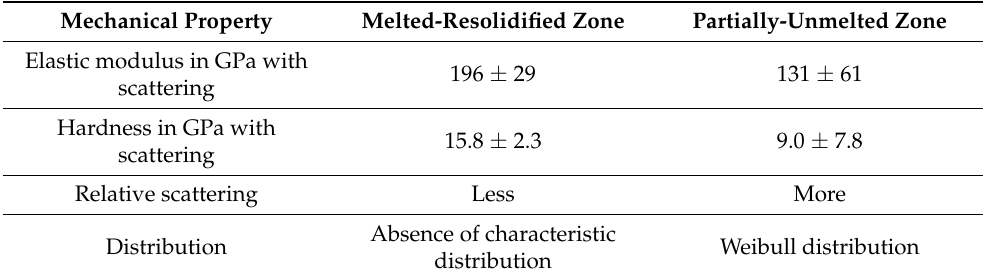
Table 2. Properties and characteristics of various zones in microstructures